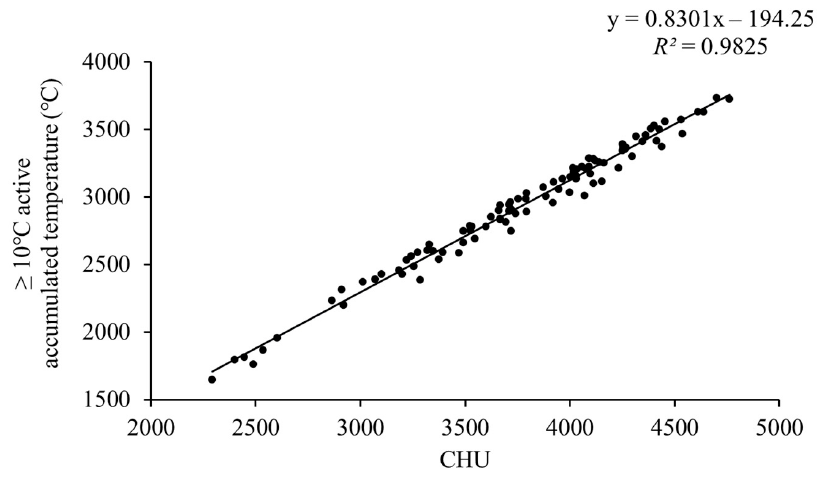
Figure 3. Relationship between annual CHU and ≥ 10 °C AAT.